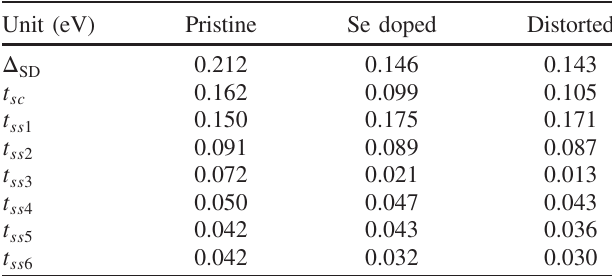
ones, making intercluster hopping of central-orbital elec- TABLE I. Single-electron parameters from Wannier function 2 Se , respectively. x x